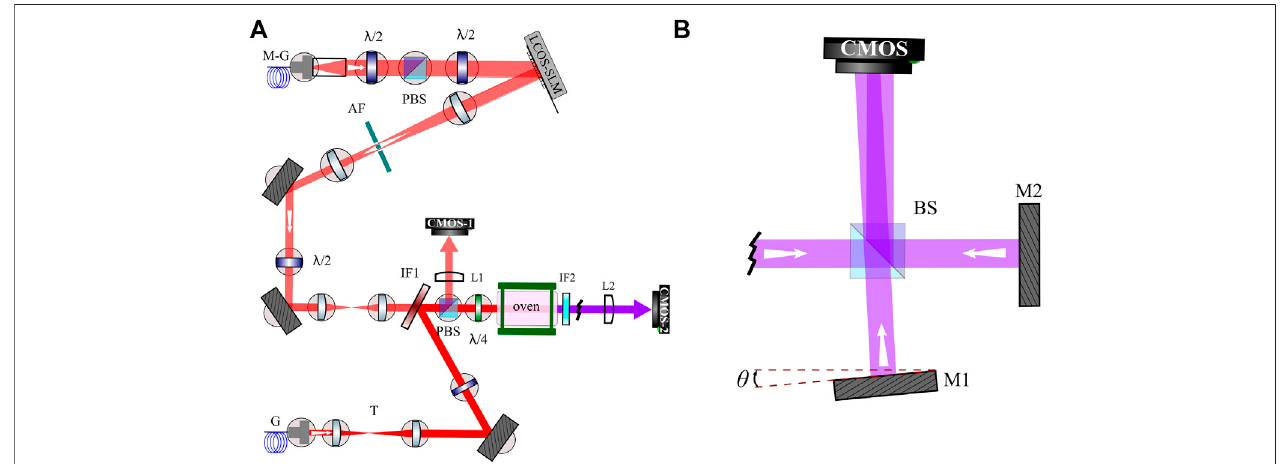
FIGURE3 | Experimental setup toinduce FWMin ahot atomic vapor ofRb 87 with one helical Mathieu – Gauss (top) and a Gaussian beam (bottom). (A) Both pump beams are prepared and overlapped through the atomic sample whilst being heated by an oven. (B) Michelson – Morley interferometer that replaces the Fourier and con fi guration analysis setup for locating the optical